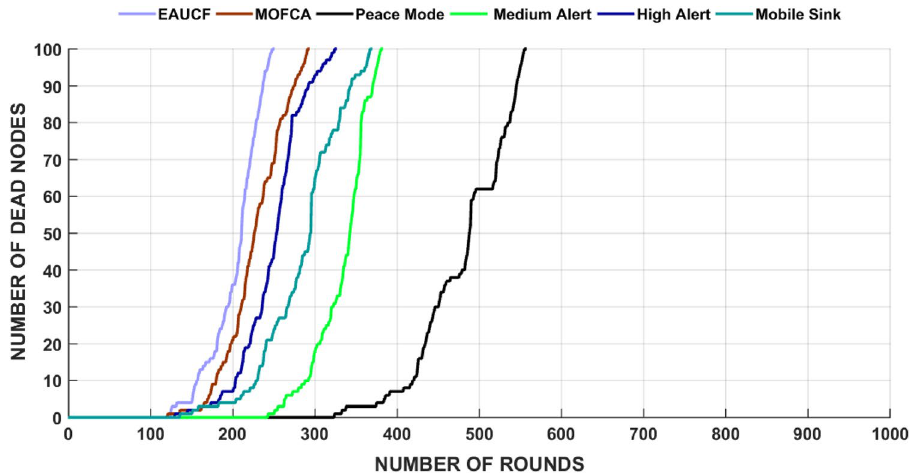
Fig. 17 Number of dead nodes in relation to the number of rounds in scenario